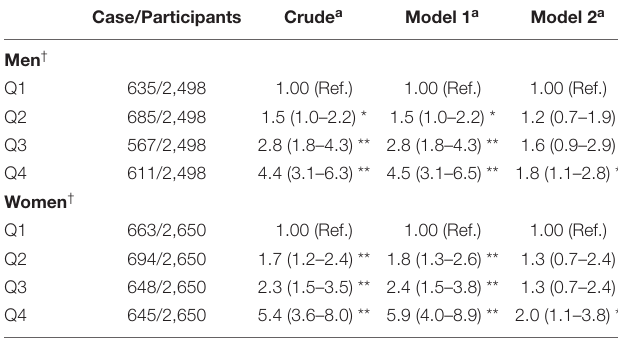
TABLE 6 | Weighted odds ratios (95% confidence intervals) for hyperinsulinemia of participants across quartiles of serum uric acid (Men = 2,498, women = 2,650).